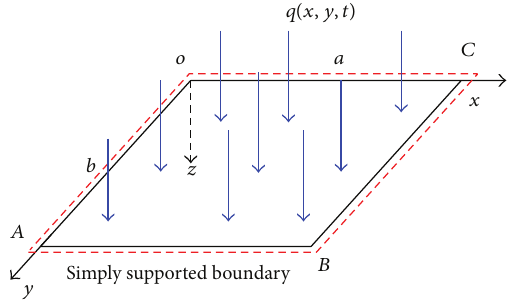
Figure 4: Scheme and configuration of the thin plate.